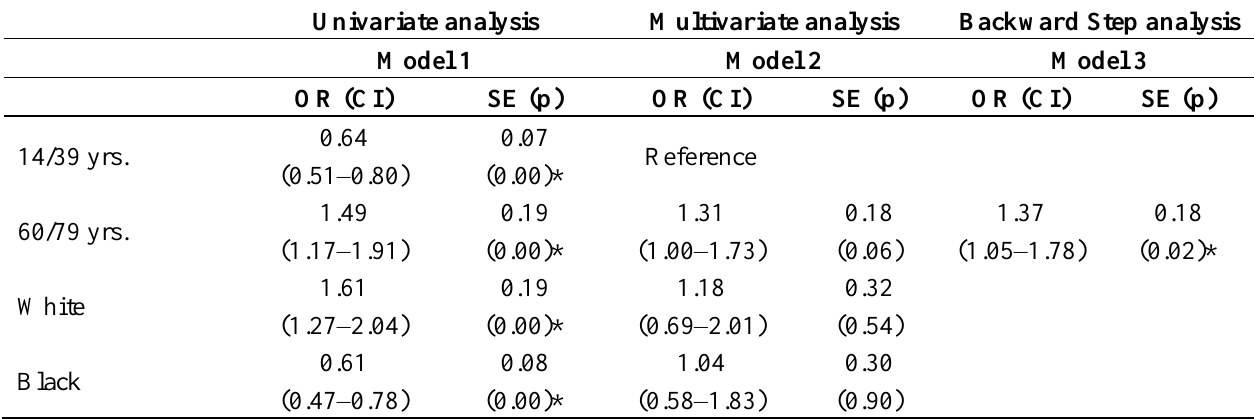
Table 6. Logistic models predicting charitable giving to youth